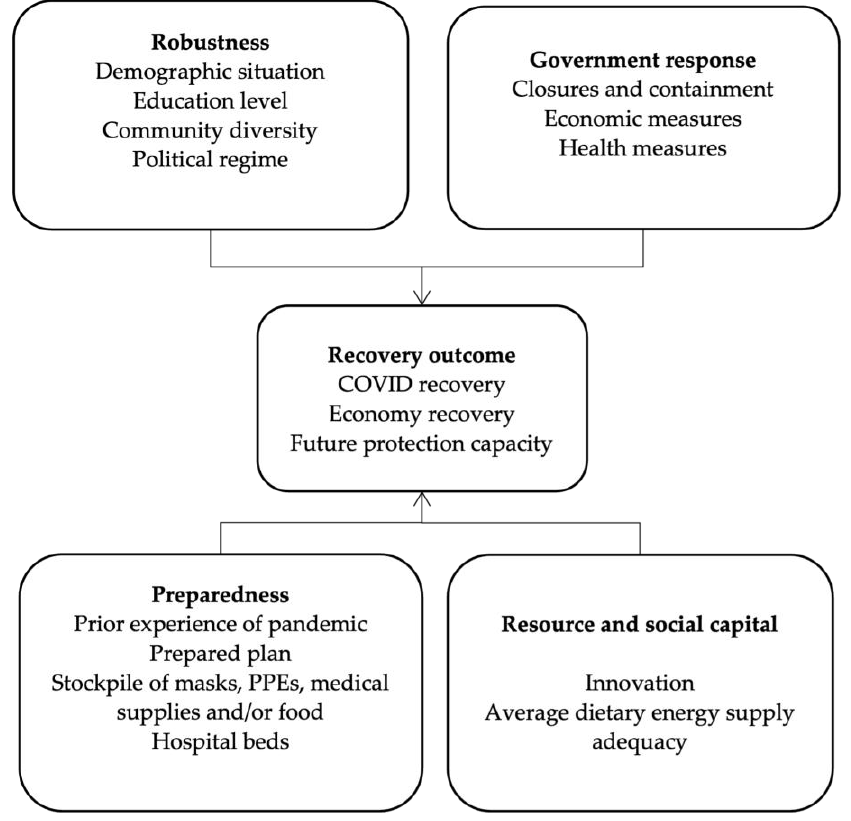
Figure 1. Theoretical framework of resilience attributes and interactions.